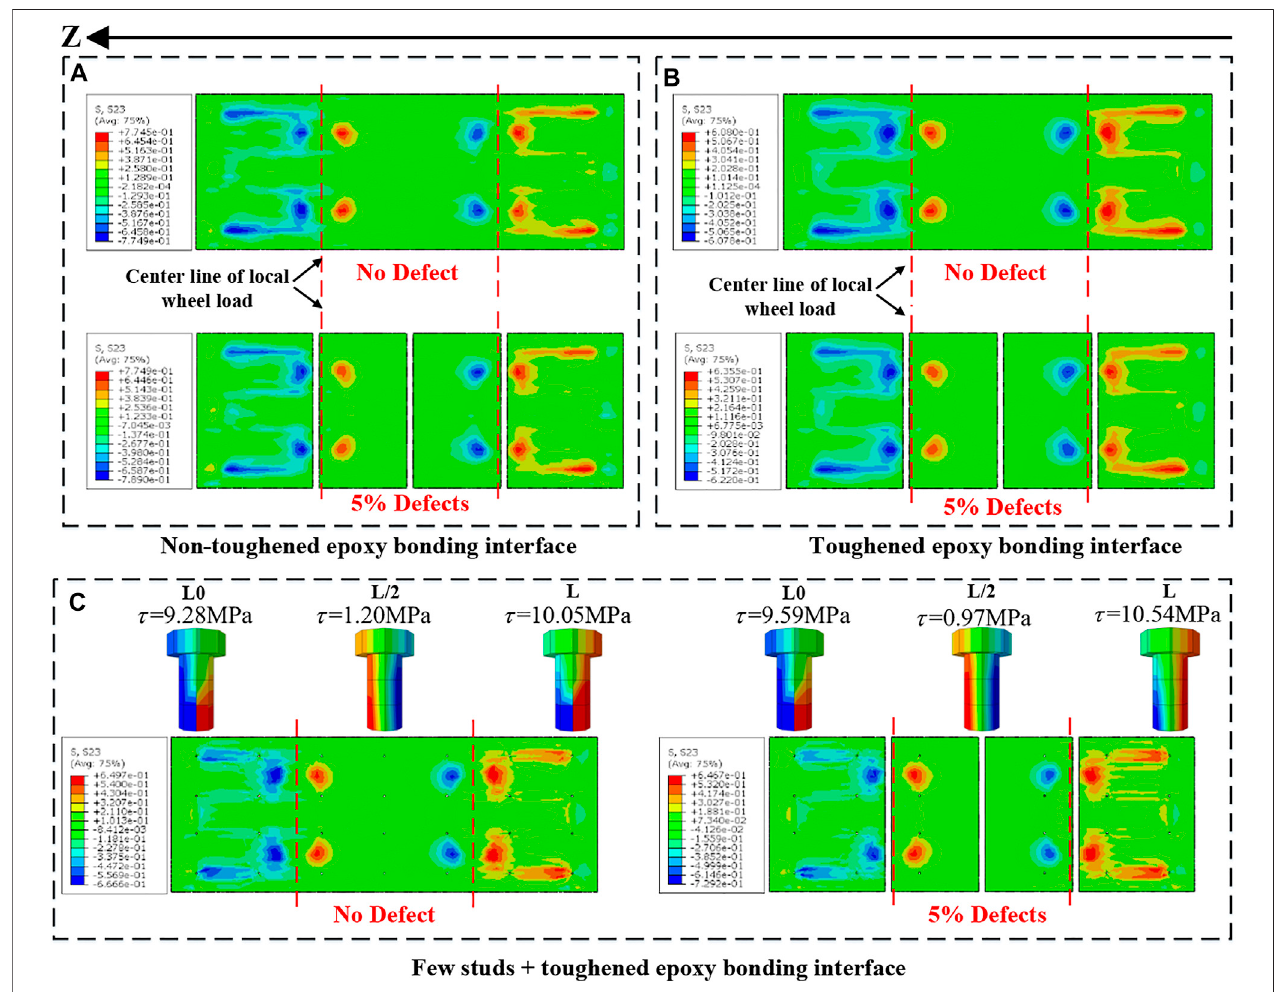
FIGURE 14 | Stress distribution before and after interface defects under the standard wheel load. (A) Non-toughened epoxy bonding interface. (B) Toughened epoxy bonding interface. (C) Few studs + toughened epoxy bonding interface. (D) Full stud connection interface.